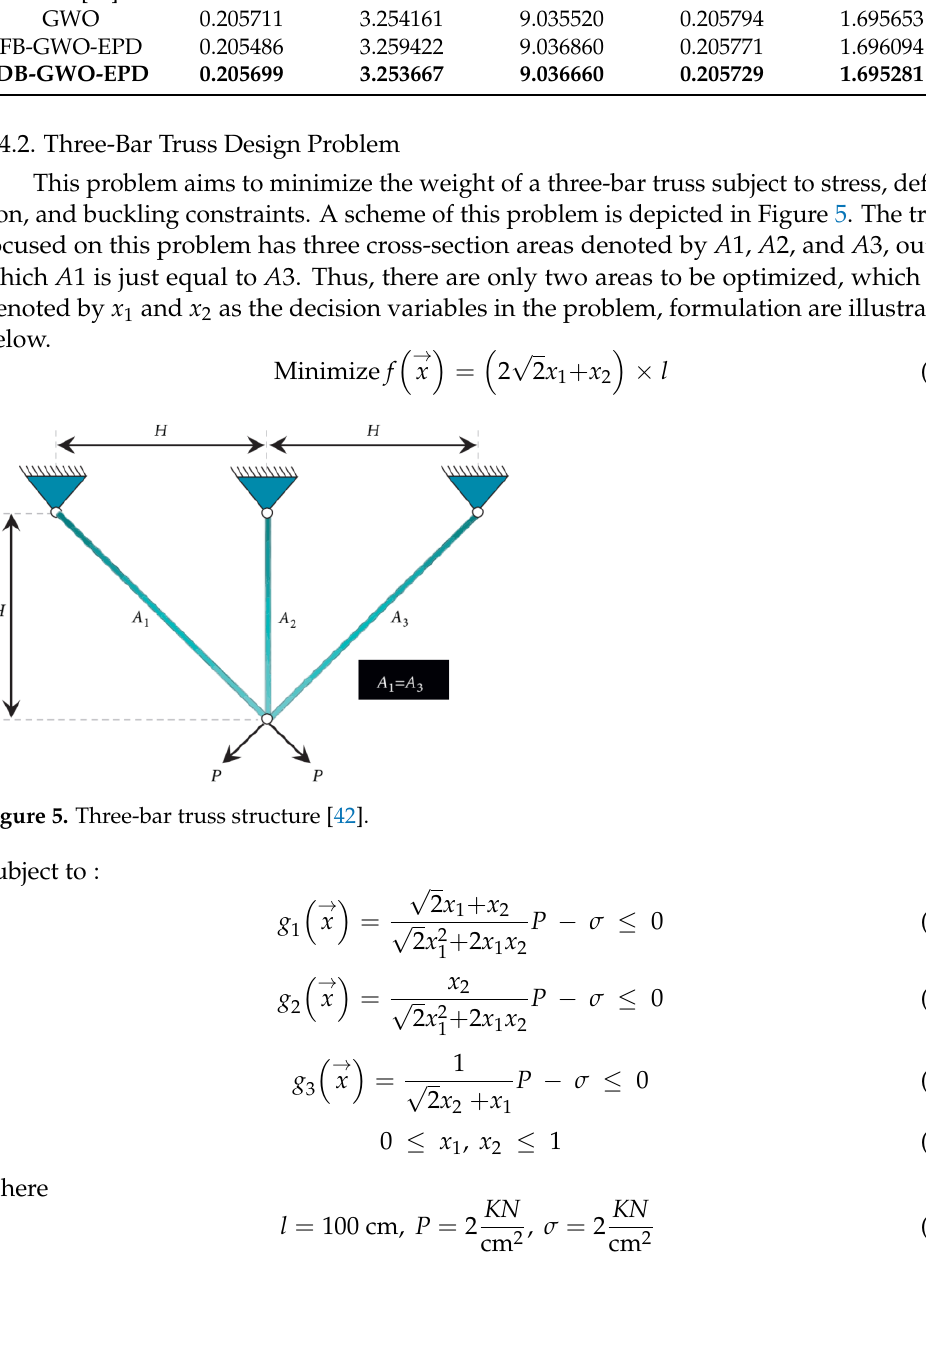
(41) Table 10. Results of solving three-bar truss design problem. Algorithm